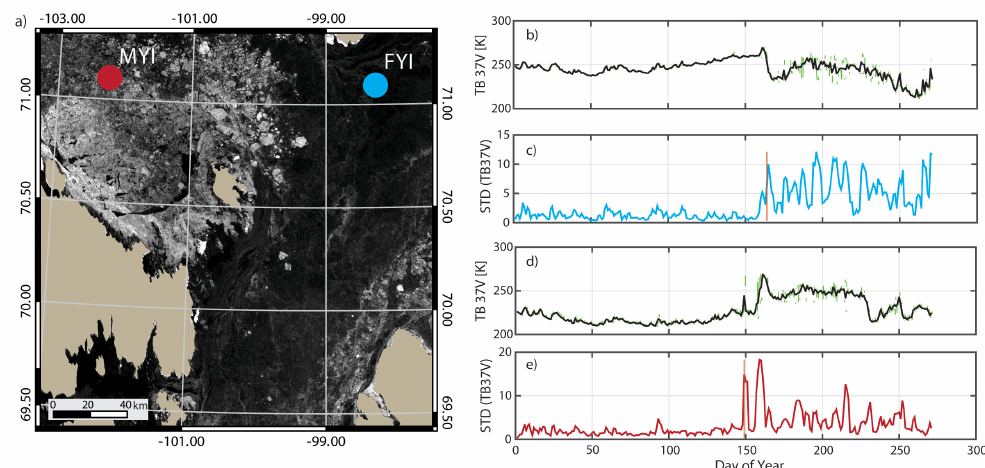
Figure 8. ( a ) Location of first-year sea ice (FYI) and multiyear ice (MYI) pixels sampled in the CAA in 2018, shown on a Sentinel-1 synthetic aperture radar image acquired on Day 126, in the late-winter period prior to MO. ( b ) Time series of 37V brightness temperature of FYI. ( c ) Time series of DTVM applied to FYI, with vertical bar denoting MO on Day 164. ( d ) Time series of 37 V brightness temperature of MYI. ( e ) Time series of DTVM applied to MYI, with vertical bar denoting MO on Day